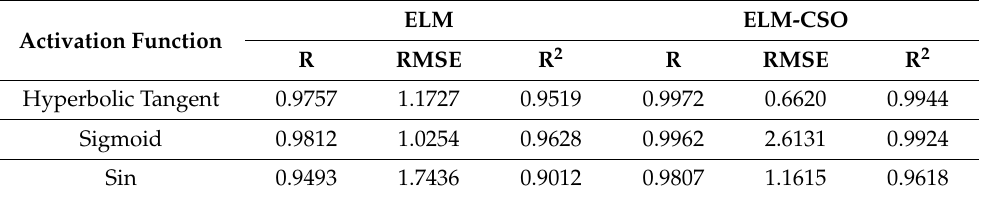
Table 5. Performance metrices of ELM and ELM-CSO methods with different activation functions.